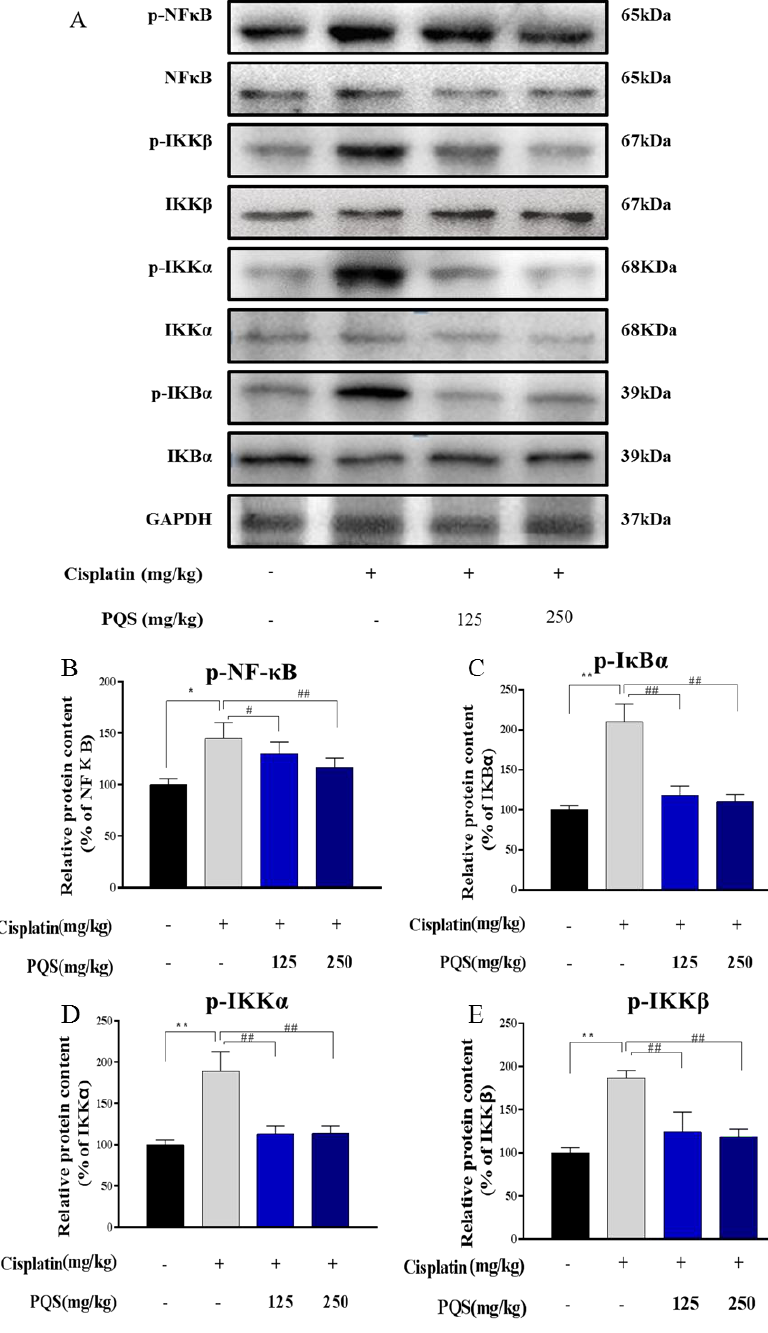
Figure 6. ( A ). Quantitative analysis of scanning densitometry for p-NF- κ B ( B ); p-I κ B α ( C ); p-IKK α ( D ); p-IKK β ( E ). All data were expressed as mean ± S.D. * p < 0.05 or ** p < 0.01 comparing with normal group. # p < 0.05 or ## p < 0.01 comparing with cisplatin